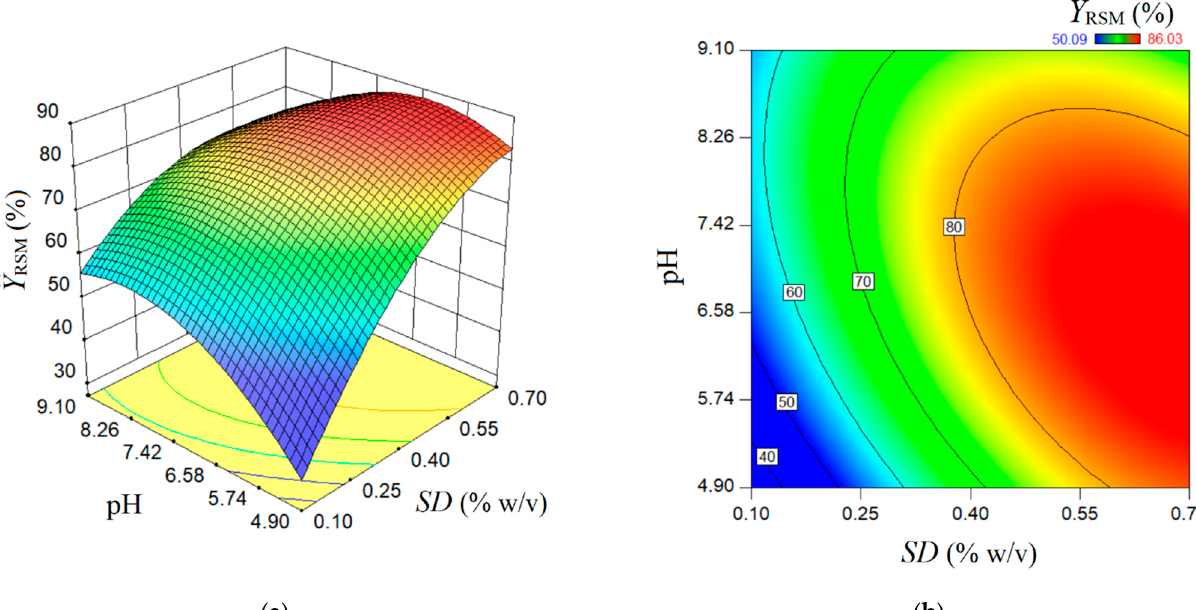
Figure 3. Predictions given by RSM model: ( a ) response surface plot (3D graph), and ( b ) contour-lines map (2D) showing the estimated response ( ˆ Y RSM ) depending on pH and SD (g/L) factors.